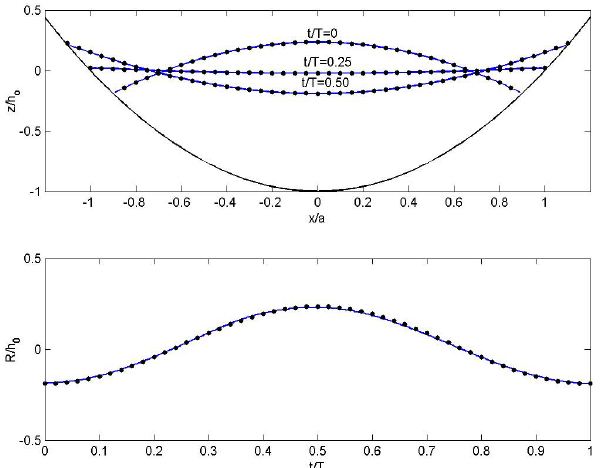
Fig. 9. Comparison between simulations (—) and analytical solu- tion ( (cid:5) ) for the long-wave oscillation in a parabolic basin. Upper: water surface profiles; lower: